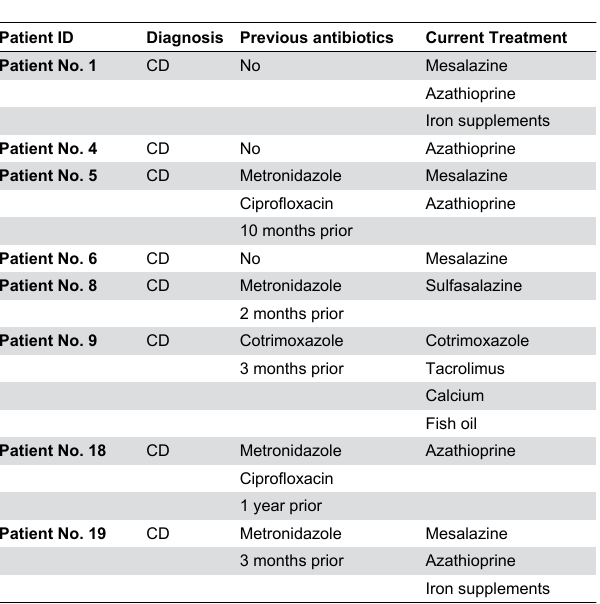
Table 2. Treatment details of patients in